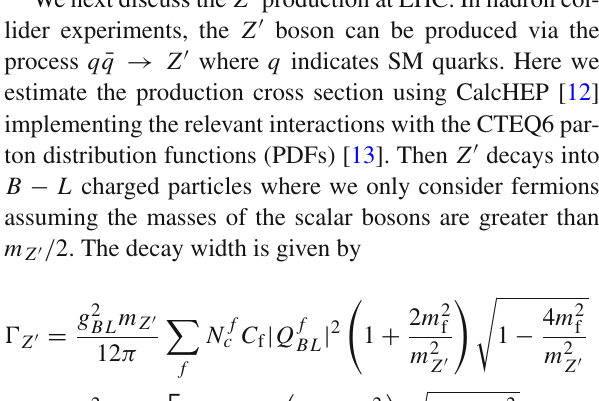
Fig. 1 The allowed regions to satisfy the neutrino oscillation data, where the upper figures represent NH and the lower one IH, while the left figures shows the mass scale of m ν in terms of z and the right ones the mass scale of m ν 11 f X M X =